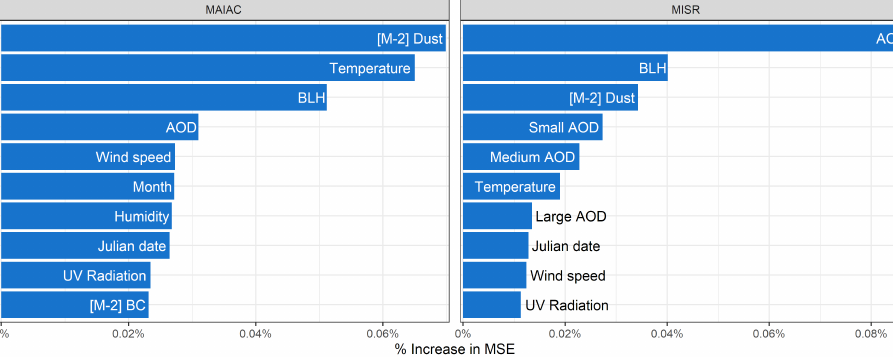
Figure 4. The top 10 most important variables for the random forest overall models using MAIAC AOD ( left ) and MISR AOD ( right ), as measured by increase in MSE when